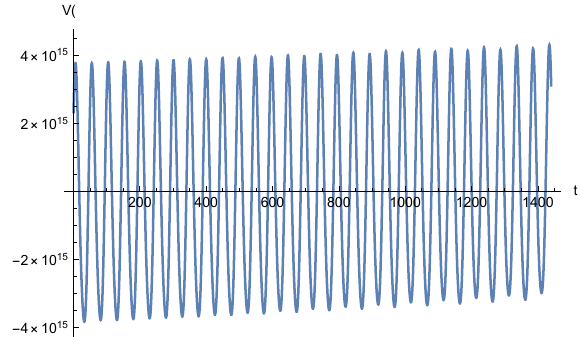
Fig. 4 Visibility Intervals Between AQUA and ARIRANG2 24-H with Air Drag